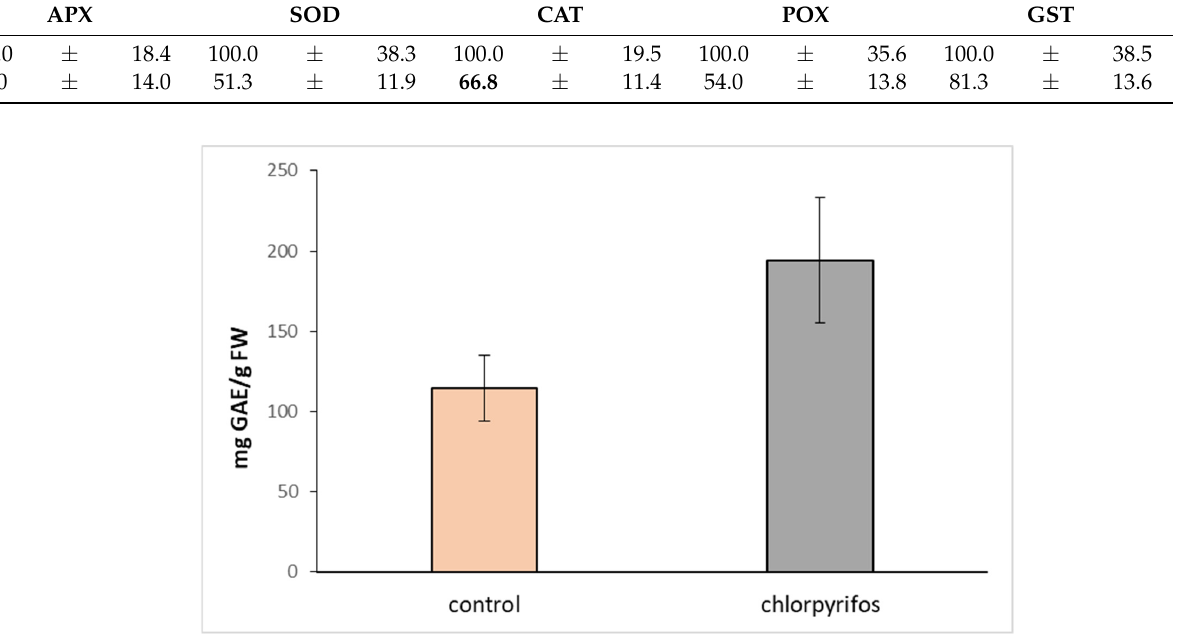
Figure 4. Total phenol content—TPC (mg GAE/g dry tissue) in the leaves of hybrid aspen. Compar- ison of the content in plants growing for 7 days in the medium supplemented with chlorpyrifos (CPS) at an initial concentration of 1 mg L − 1 and control plants. Data represent the mean ± S.D. ( n = 4). The statistical analysis showed a significant difference ( p <